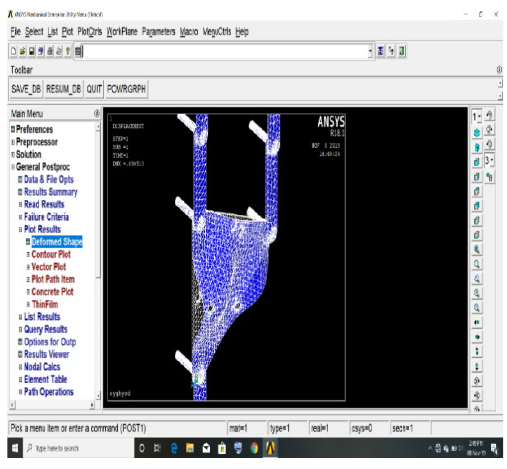
Figure 7. Von Misses Criteria Nodal Solution